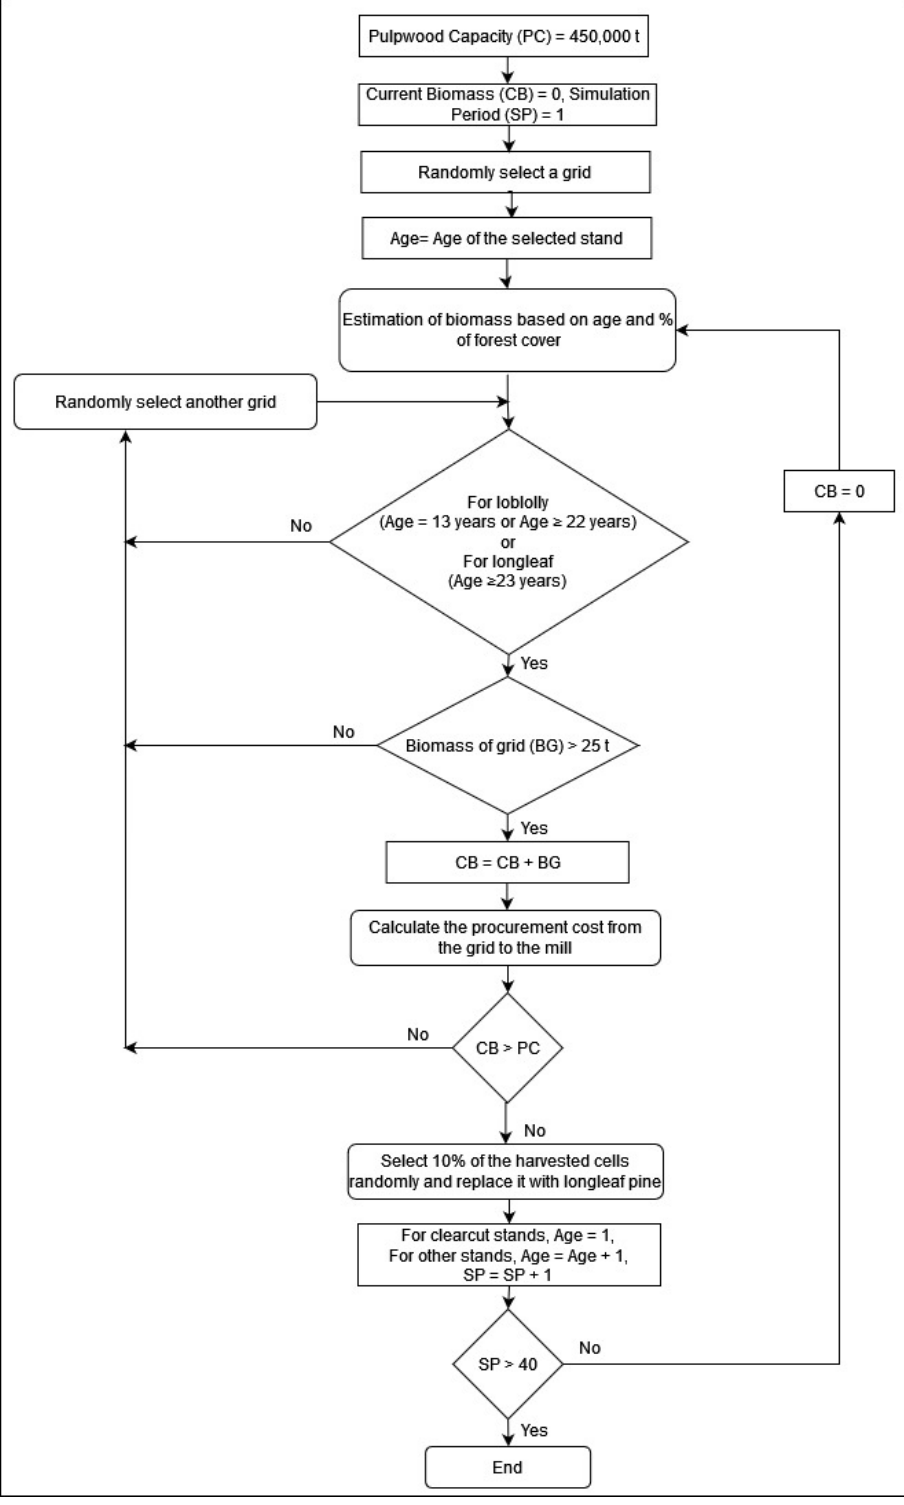
Figure 3. The flowchart for simulating Scenario 3. Suitable changes are made for simulating other selected